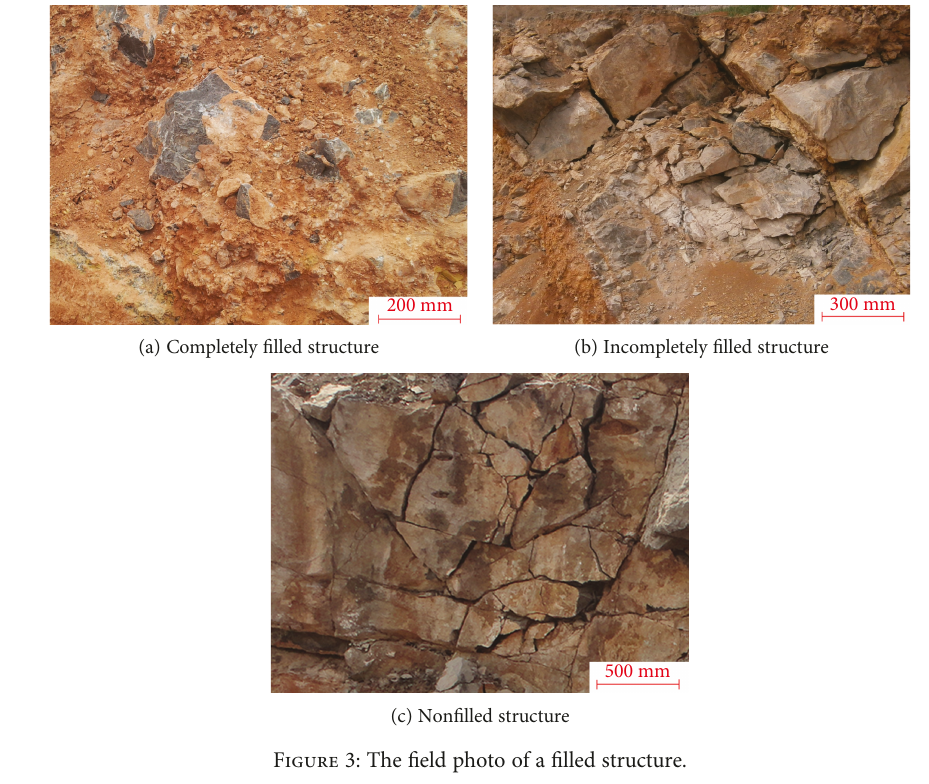
Figure 3: The fi eld photo of a fi lled